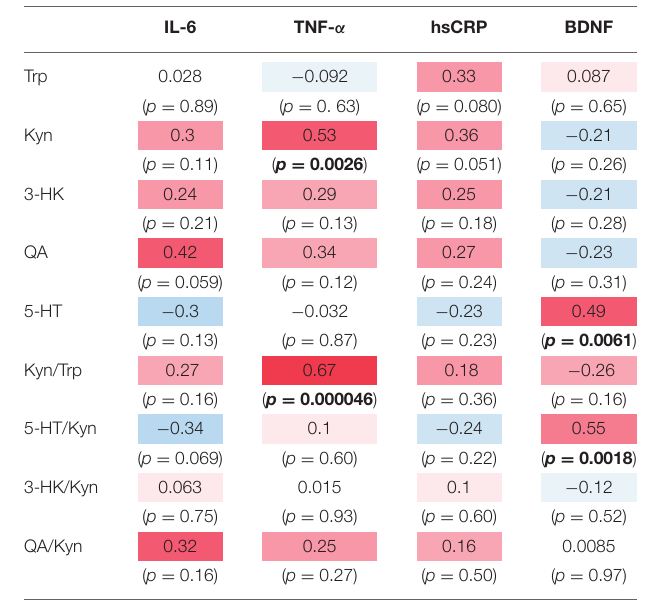
TABLE 4A | Relationship between metabolites of the Kyn pathway and cytokines, hsCRP, and BDNF in the schizophrenia group.